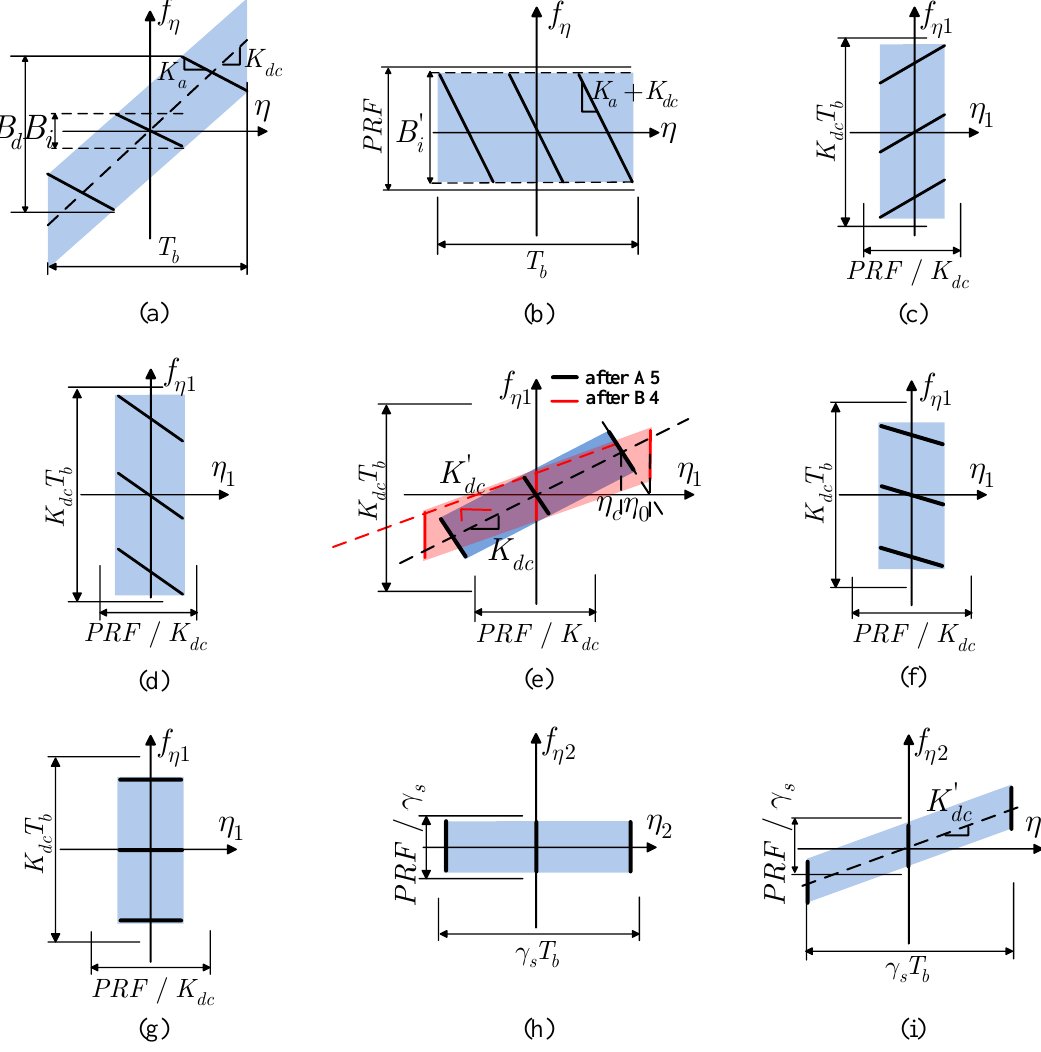
Figure 3. Azimuth time frequency diagram (TFD). ( a ) echo signal; ( b ) after A1; ( c ) after A2; ( d ) after A3; ( e ) after A5 and after B4; ( f ) after C1; ( g ) after C3; ( h ) after C4; ( i ) after